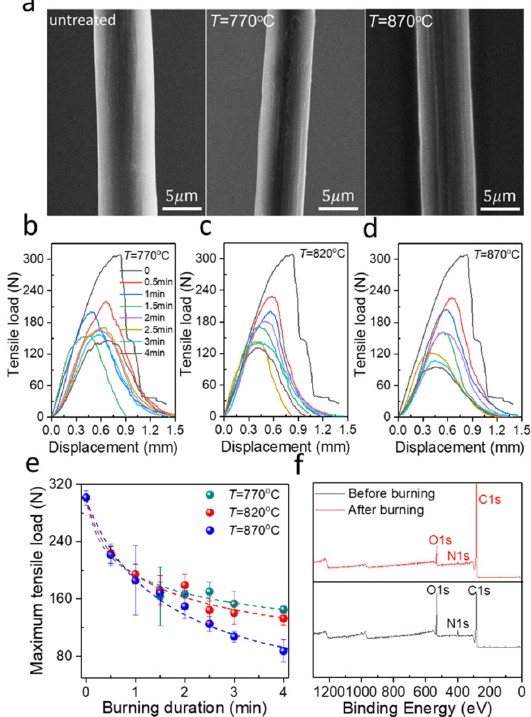
Figure 2. Properties of burned CF yarn. ( a ) SEM images of pristine and burned CFs. Load–displacement curve of CF yarns heated at ( b ) 770 ◦ C, ( c ) 820 ◦ C, and ( d ) 870 ◦ C for different durations. ( e ) Maximum tensile load vs. burning duration. ( f ) XPS spectra of pristine and CF yarns heated at 870 ◦ C for 4